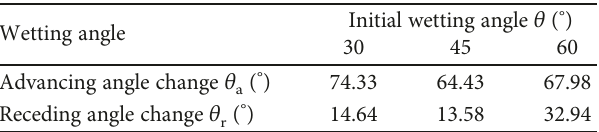
Table 3: The change of advancing and receding contact angle (initial wetting